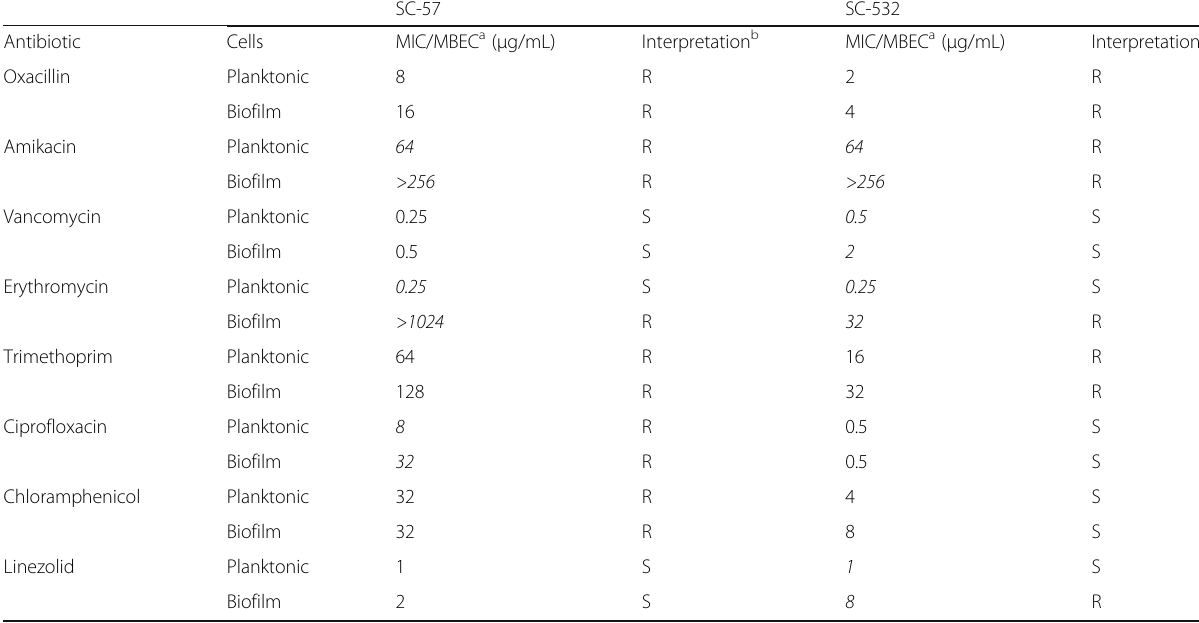
Table 5 Antibiotic resistance of biofilm and planktonic cells of SC-57 and